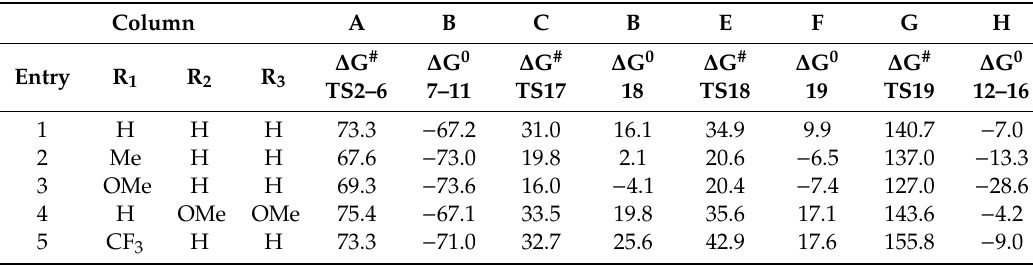
Table 2. Energetics for the alkylation of chrysin ( 1 ) and the following Smiles rearrangement. ∆ G # [kJ mol − 1 ] refers for the activation Gibbs free energy computed from the di ff erences of the transition states ( TS2 – 6 ) and the single reactants. ∆ G 0 [kJ mol − 1 ] refers to the formation Gibbs free energy of products 7 – 11 from the single